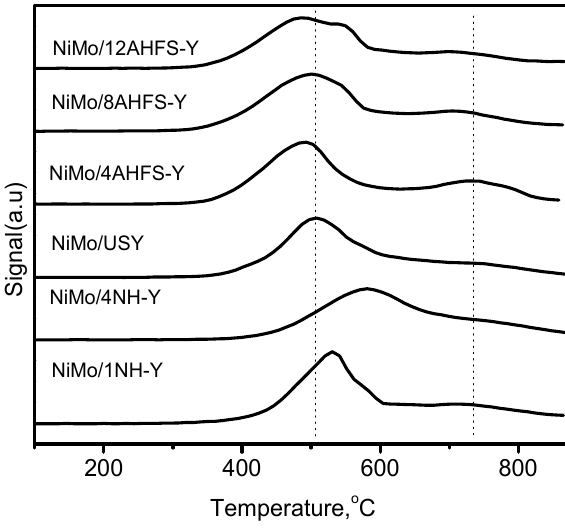
Figure 3. H 2 -TPR profiles for NiMo catalysts supported on AHFS-treated USY and alkaline-treated USY.